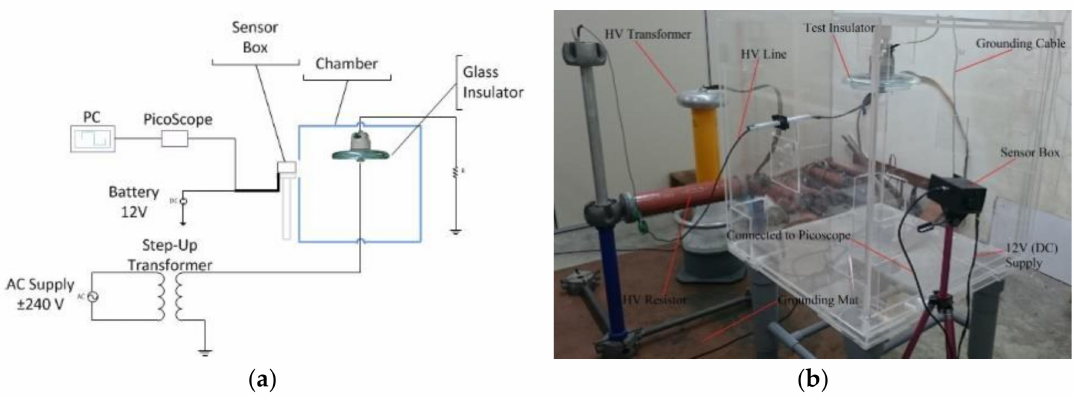
Figure 1. Experimental setup: ( a ) schematic diagram and ( b ) pictorial